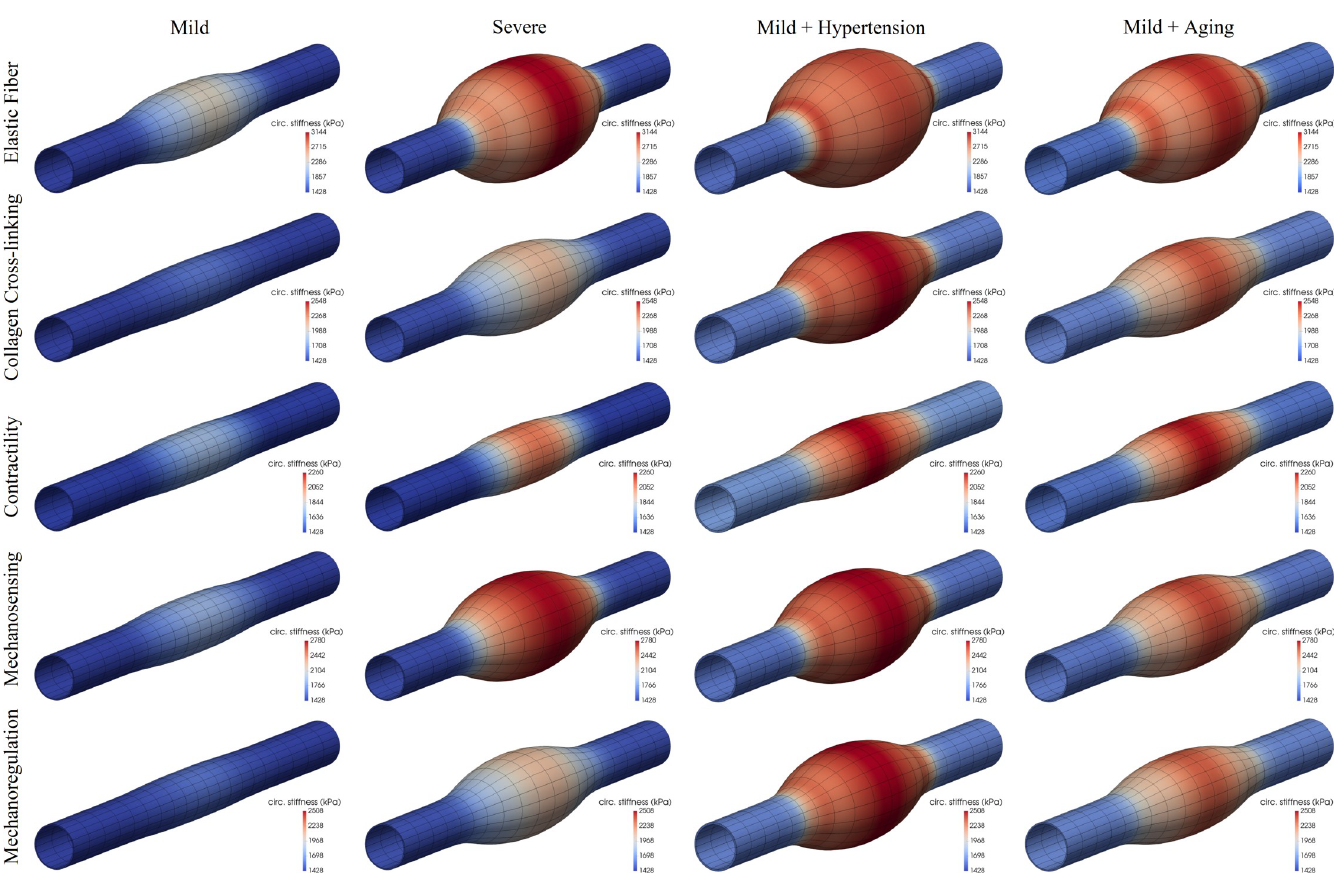
Fig 2. Same as Fig 1 except color maps for circumferential material stiffness for the mechanically-loaded geometries. Note the original in vivo homeostatic value c θθθθo = 1428 kPa (dark blue, bottom mark) as well as an increased stiffness at the shoulder of some of the lesions resulting from a locally increased α 0 h (i.e., higher λ θh / λ zh , see Eq